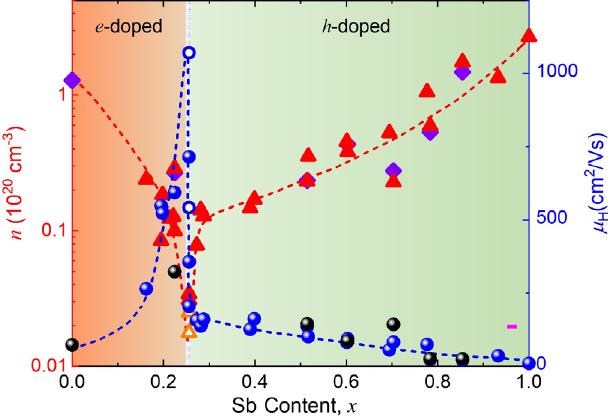
FIG. 3. Composition dependence of carrier density n and transport mobility μ of Mn ð Bi 1 − x Sb x Þ 2 Te 4 . For heavily and H moderately doped samples showing linear or almost linear ρ yx (Fig. 1 and Supplemental Material, Fig. S1 [48]), n is obtained from the linear slope of ρ yx ð H Þ at T ¼ 2 K for the FM phase (purple diamond) and 75 K for the PM phase (red triangle). The black and blue circles represent transport mobility μ H ½¼ R = ρ 0 Þ(cid:2) for the FM and PM phases, respectively. For lightly xx ð H hole-doped samples (from the x ¼ 0 . 26 batch) with nonlinear ρ H Þ , n (empty orange triangle) and μ (empty blue circle) are yx ð H extracted from the two-band model fit (see Supplemental Material, Sec. S2 [48]), and only the data of dominant bands are presented here. The magenta bar represents the maximal statistical error of the measured Sb content by